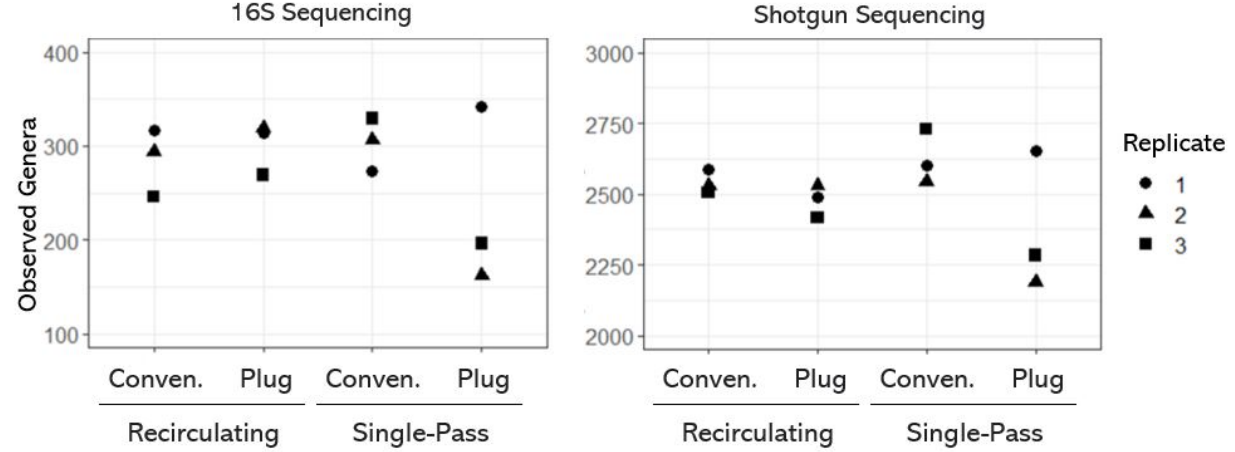
Figure 2. Total taxa in each OWTS identified by 16S and shotgun sequencing. Conventional and plug-flow systems are labelled Coven and Plug, respectively.